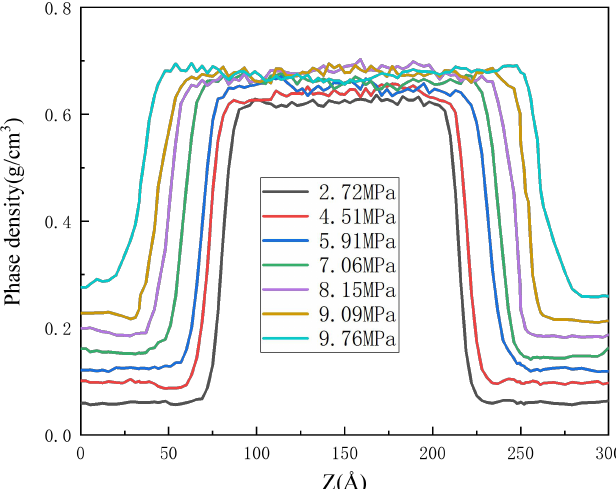
Figure 4 — Variation of gas-liquid phase density with pressure of CO 2 /n-decane